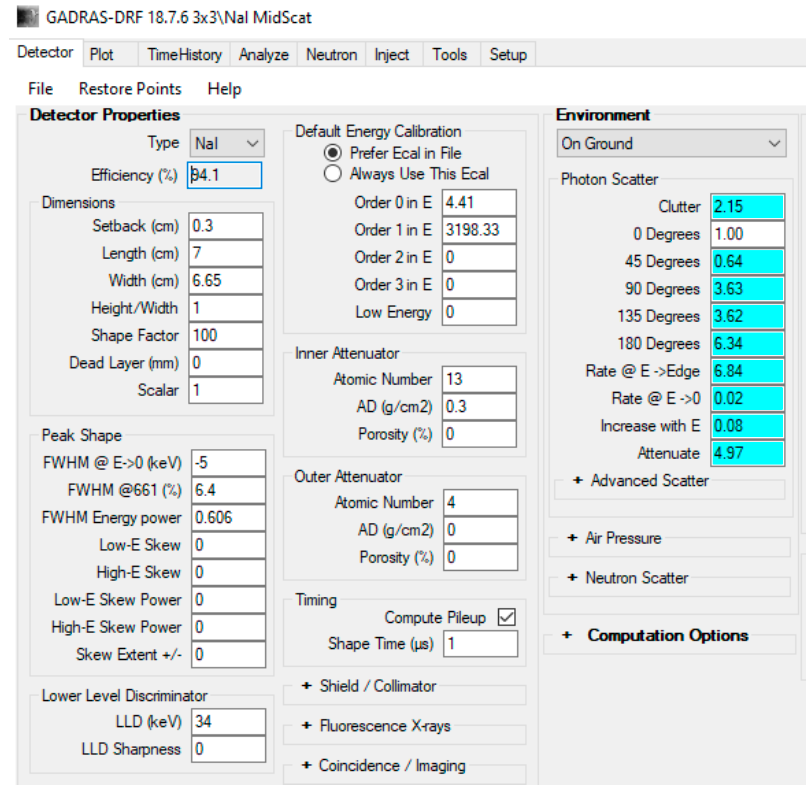
Figure 1. NaI Detector parameters used in the GADRAS